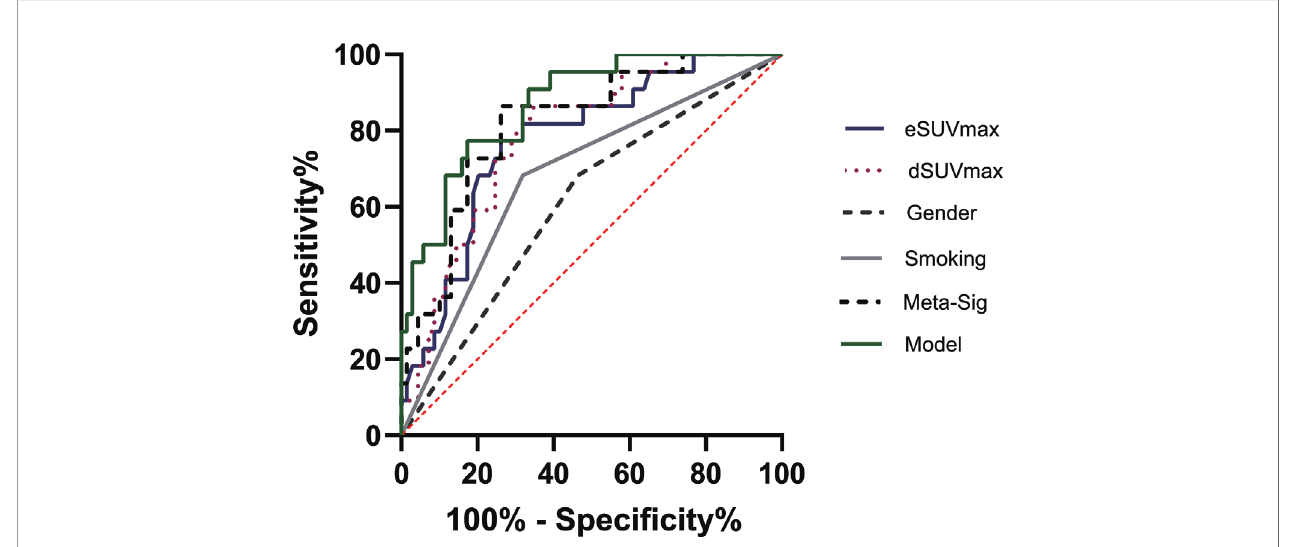
FIGURE 7 | Representative image of receiver operating characteristic (ROC) curves for various factors in the analyses of TMIT I tumors. The combined model had the highest AUC than other factors.